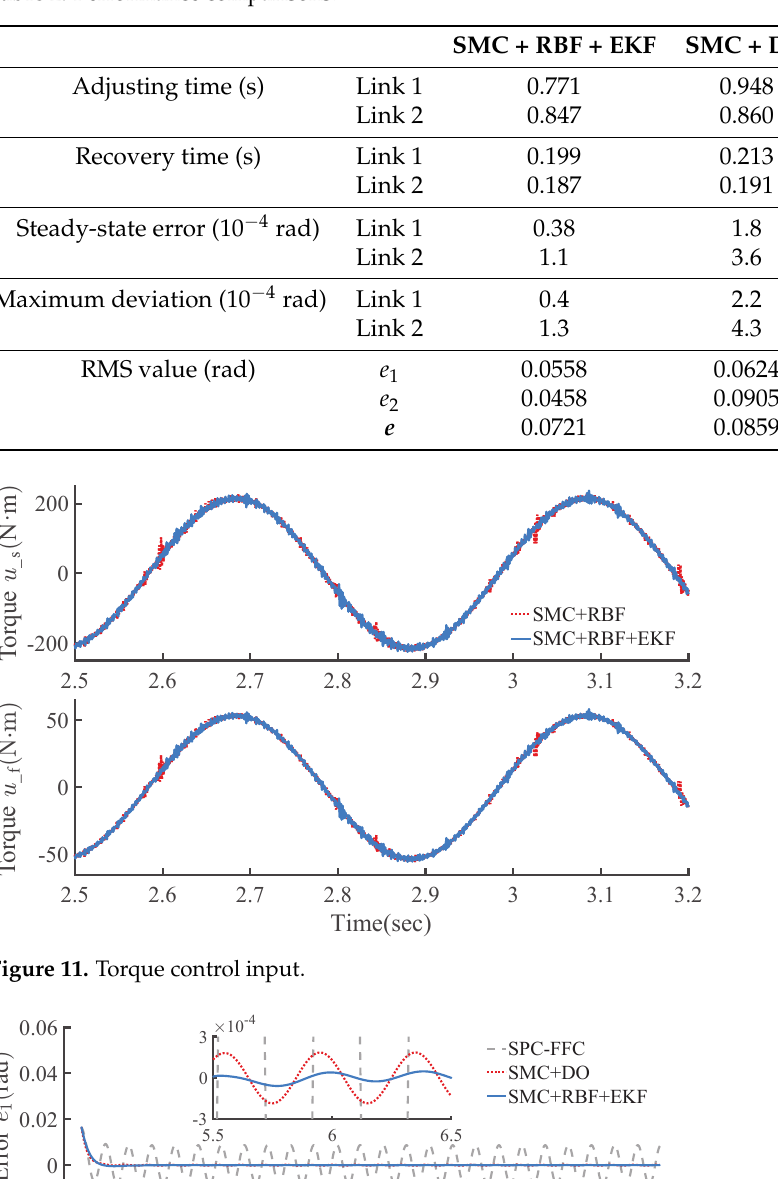
Table 2. Performance comparisons.